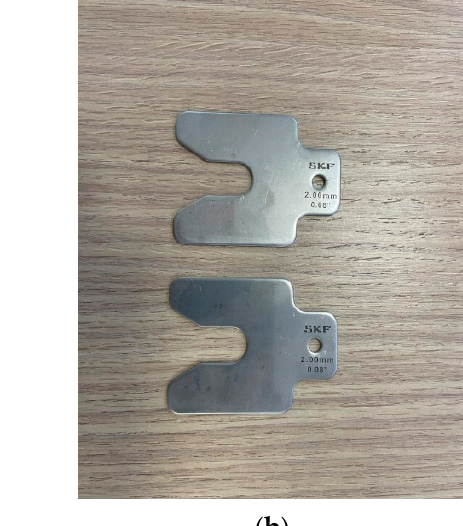
Figure 7. ( a ) Shim on the back SynRM mounting, ( b ) 2 mm shims used to force misalignment in the SynRM.